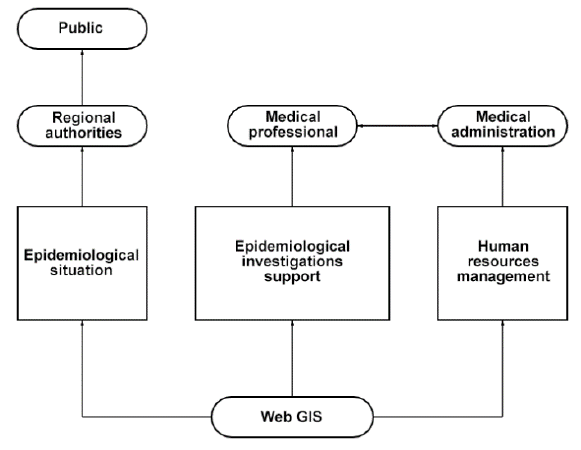
Figure 10. Application domains for the FEBRIS